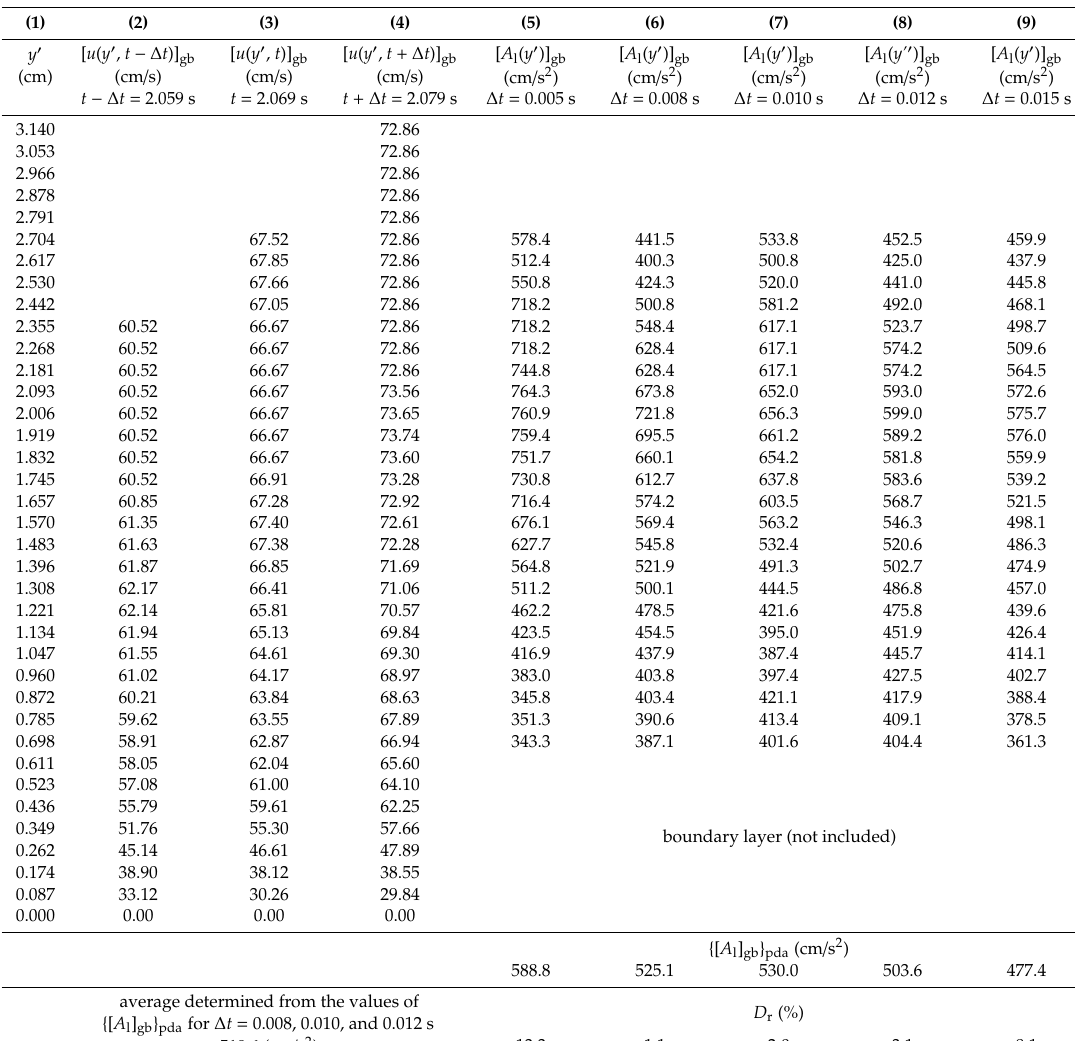
Table A1. List of velocity data at di ff erent times and calculation of local acceleration [ A l ( y (cid:48) )] gb for t = 2.069 s with five di ff erent time intervals. Note that partially depth-averaged values of local acceleration {[ A l ] gb } pda and their relative deviations D r are addressed at the bottom of the